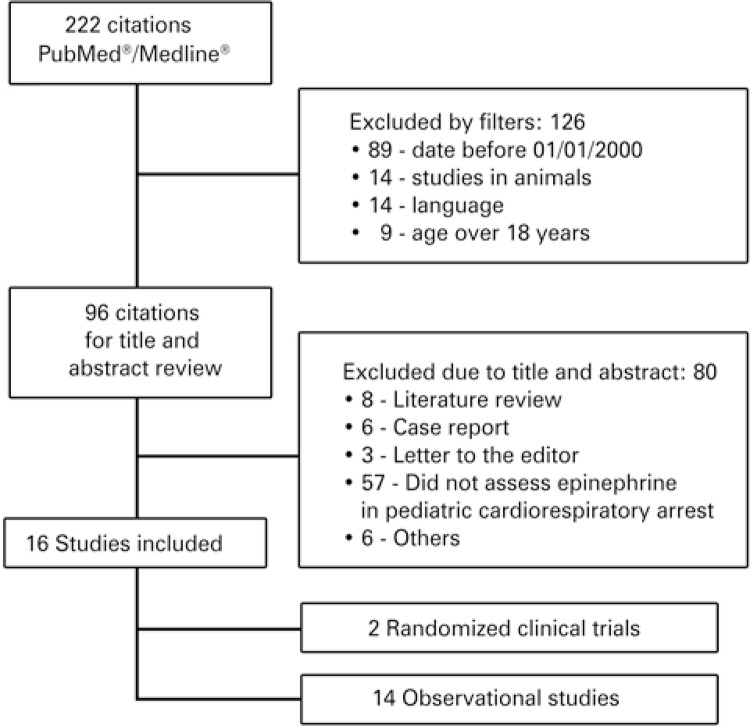
Study flow chart